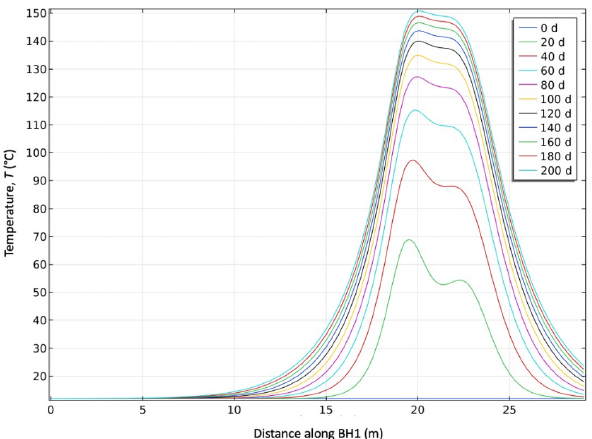
Figure 7. Evolution of the temperature along BH1 during the ther- mal